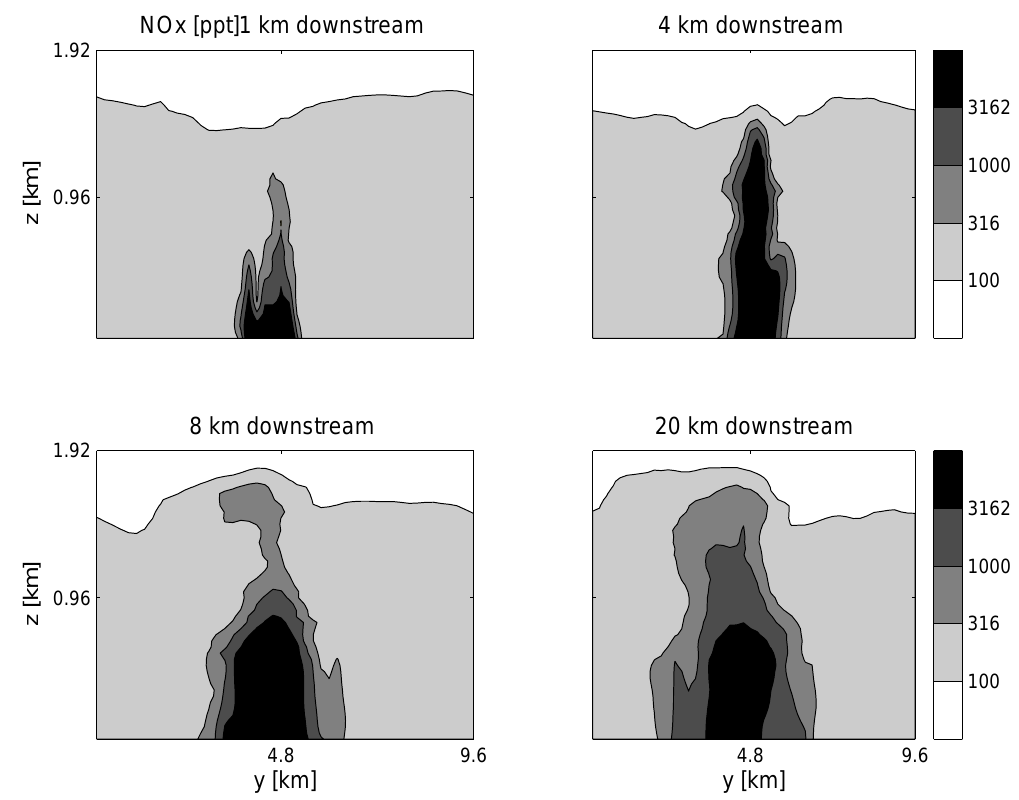
Fig. 2. Vertical sections of NO x across the plume at noon (local time) on day 2 for the highest resolution (C1) experiment at 1, 4, 8 and 20km downstream from the source. Contour intervals are base 10 logarithmic in units of